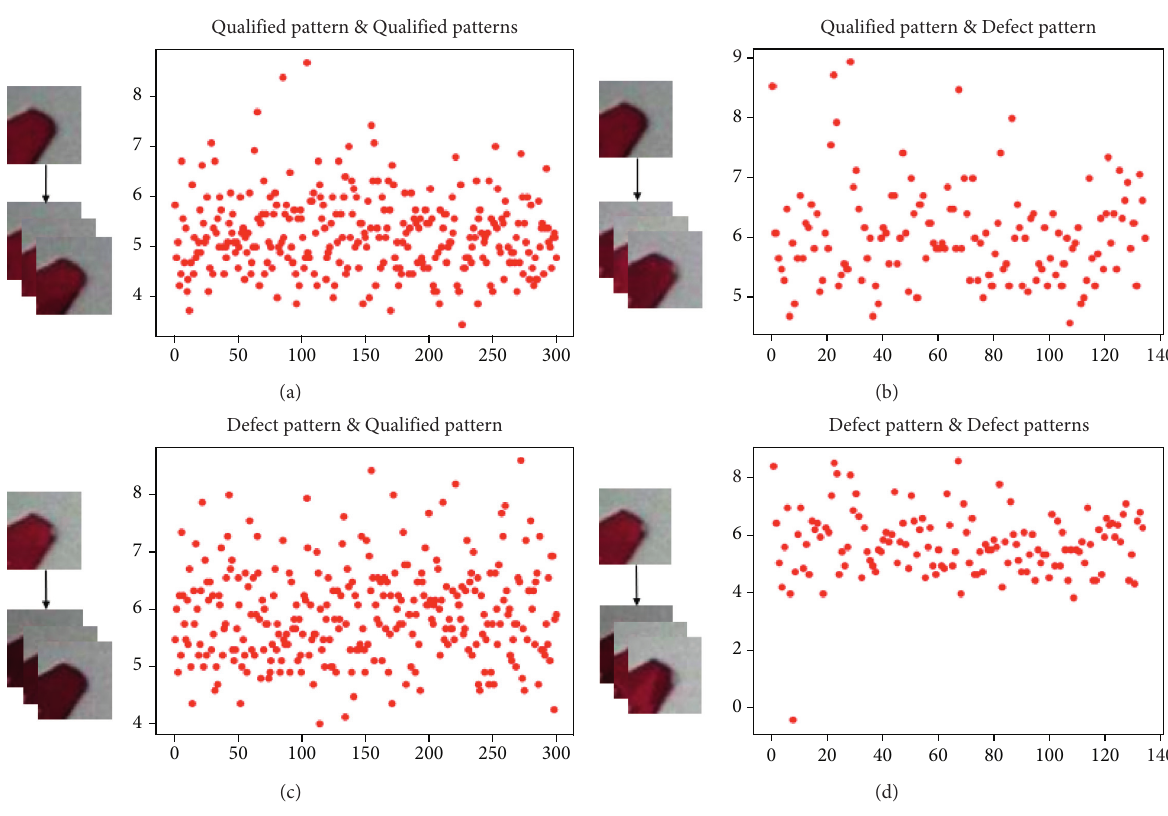
Figure 6: The similarity matching results of different pattern types. (a) The qualified pattern matches the qualified patterns. (b) The qualified pattern matches the defective patterns. (c) The defective pattern matches the qualified patterns. (d) The defective pattern matches the defective patterns. The horizontal axis represents the number of similarity matches. The vertical axis represents the similarity matching results (similarity matching score). In (a), there are 300 red points, and each point represents a matching result. The block pattern without superposition is a qualified pattern. The section superimposed by three block patterns represents the other 300 qualified patterns. In (b), there are 135 red points, and each point represents a matching result. The block pattern without superposition is a qualified pattern. The section superimposed by three block patterns represents the other 135 defective patterns. In (c), there are 300 red points, and each point represents a matching result. The block pattern without superposition is a defective pattern. The section superimposed by three block patterns represents the other 300 qualified patterns. In (d), there are 135 red points, and each point represents a matching result. The block pattern without superposition is a defective pattern. The section superimposed by three block patterns represents the other 135 defective patterns.